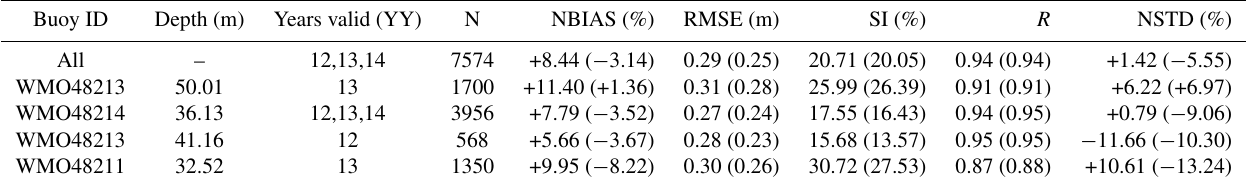
Table A1. H s error metrics for select years in the Beaufort–Chukchi seas using CFSR and ERAI in parentheses. Buoy ID